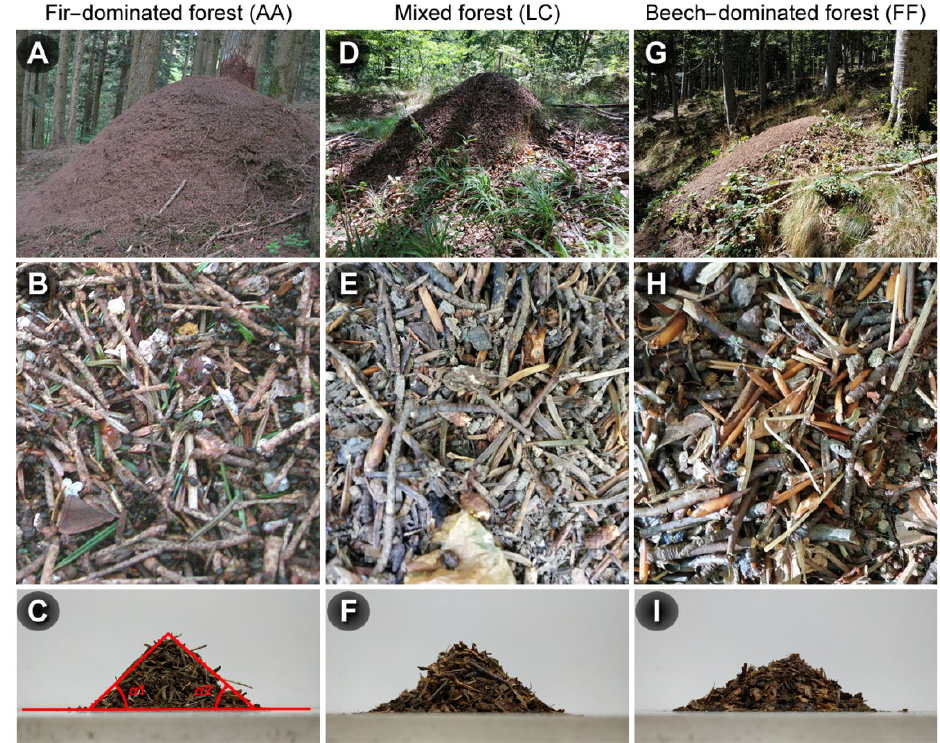
Figure 2. Examples of mound shape ( A , D , G ), nesting material composition ( B , E , H ), and angle of repose ( C , F , I ) at the three sites. In C, the two angles (α1 and α2) used for assessing the angle of repose are indicated in red, with the average of these values reported.